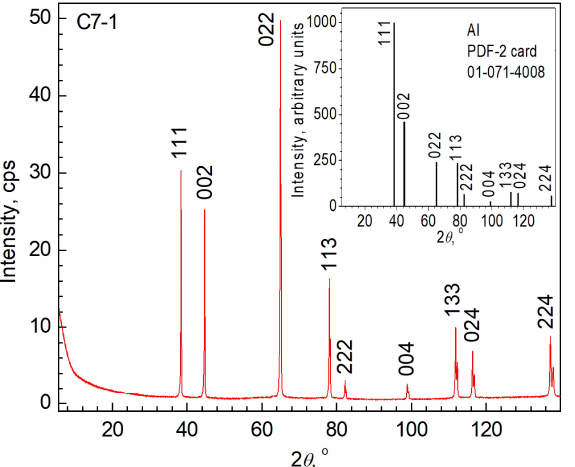
Figure 3. XRD patterns from sample C7-1. Miller indices hkl of Al reflections are indicated. The inset shows the XRD pattern of the Al phase according to PDF-2 card 01-071-4008 [26] at a temperature T = 312.3 K, which is close to the temperature of XRD measurements, T = 314 ± 1 K.